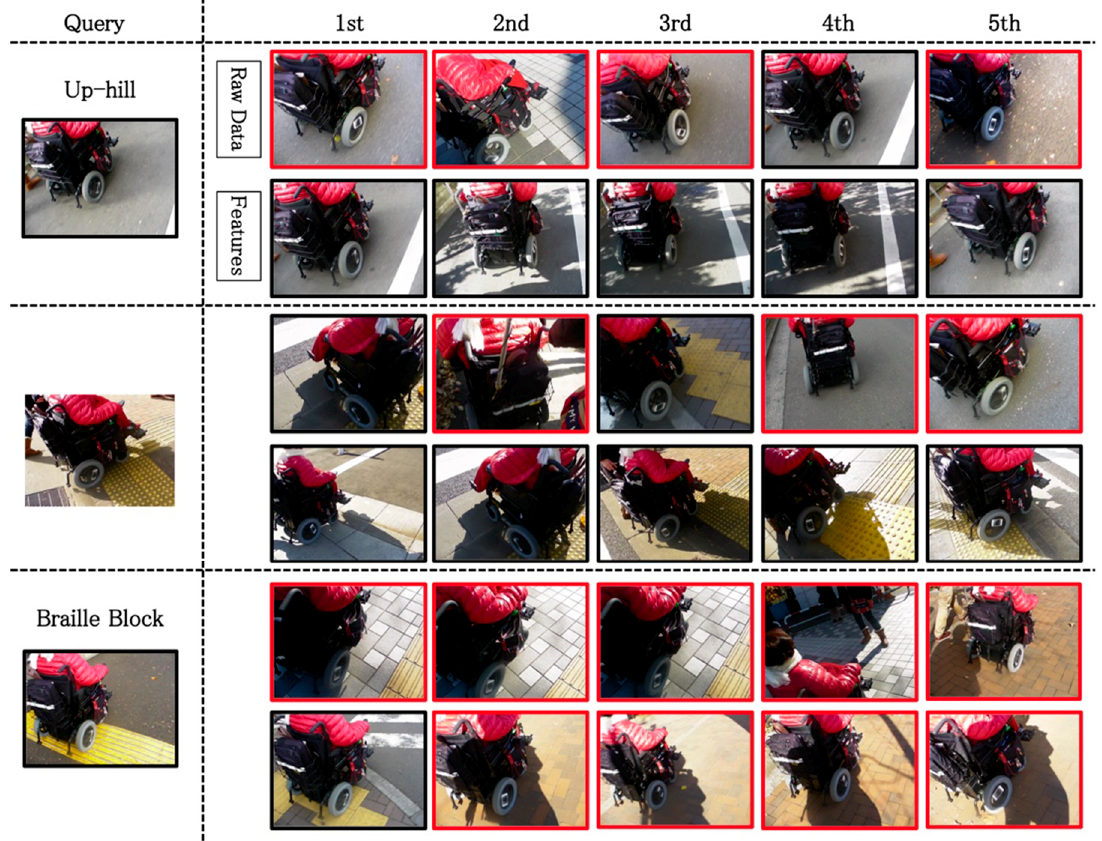
Figure 7. Similar road surface search results using DCNN feature output obtained by inputting acceleration data and raw acceleration data.